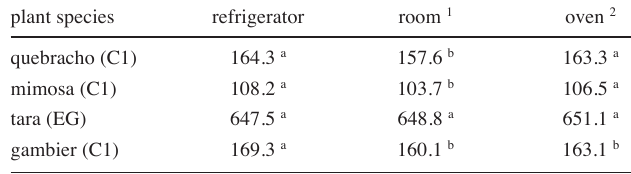
Tab. 6: Tannin content of the extracts in g kg −1 by HPLC-MS analysis as influenced by different storage conditions, quantified based on pro